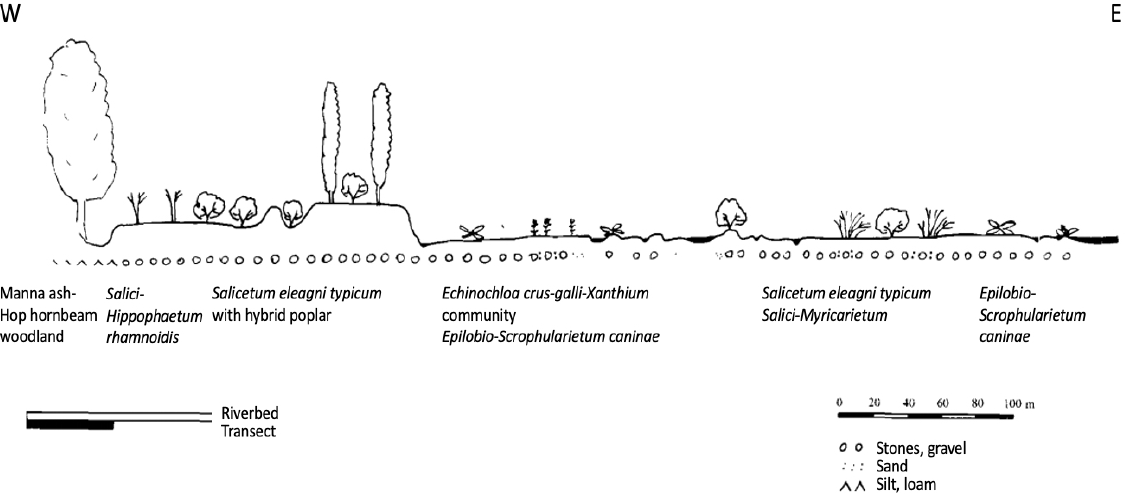
Figure 5. A cross-section of plant communities along the middle course of the Tagliamento River (W–E orientation) (from [42]).